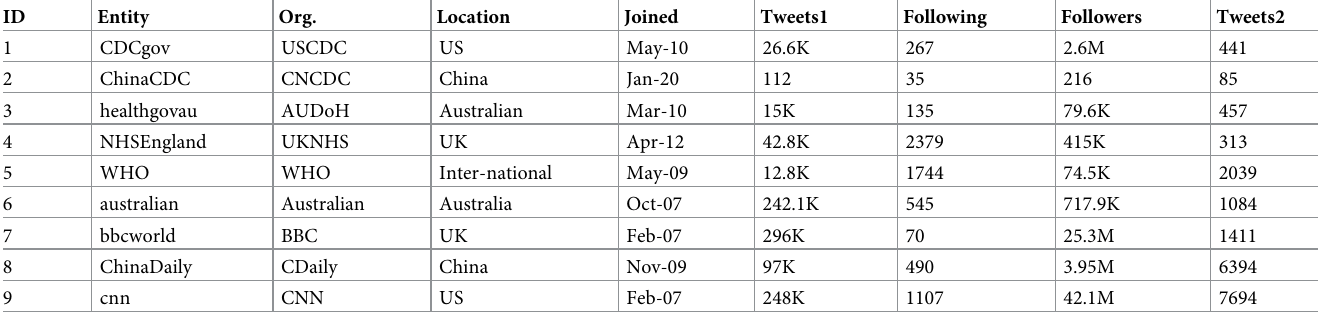
Table 1. Statistics of the Twitter accounts of the nine studied public